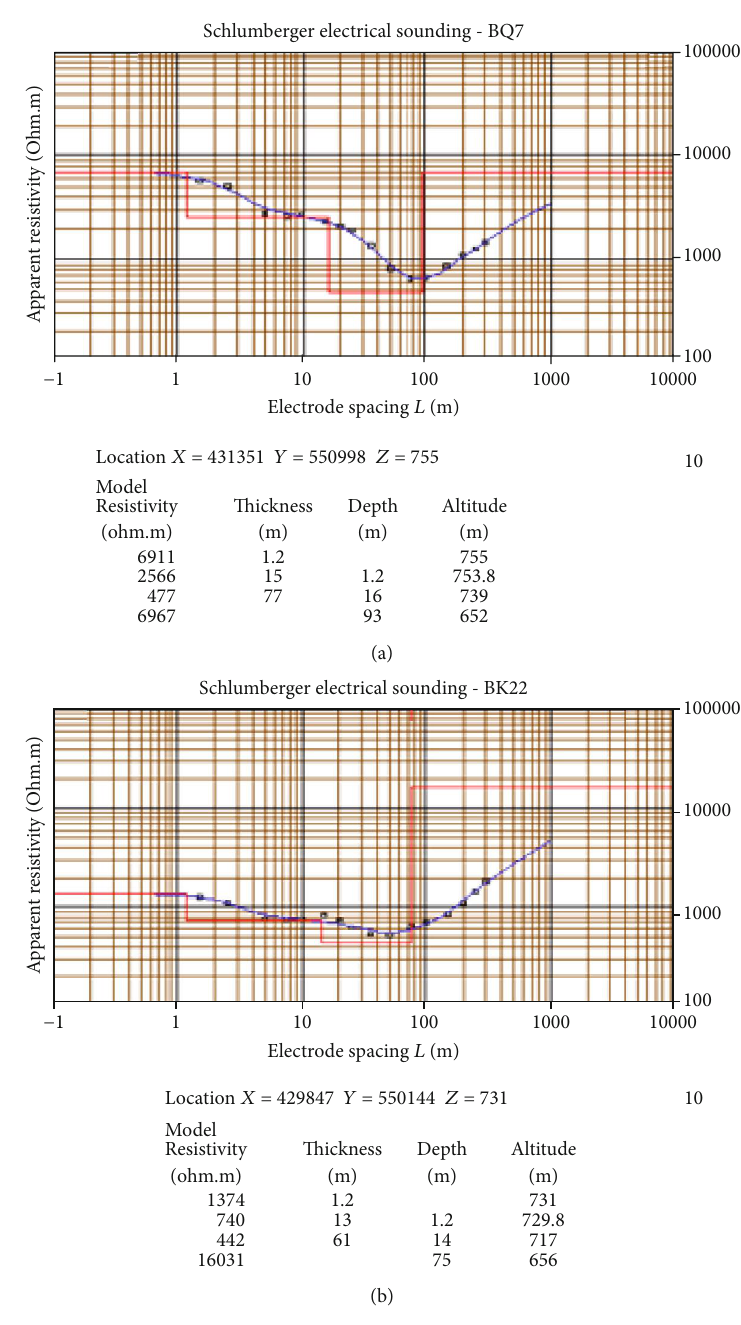
Figure 9: (a, b) Sounding curves (BQ